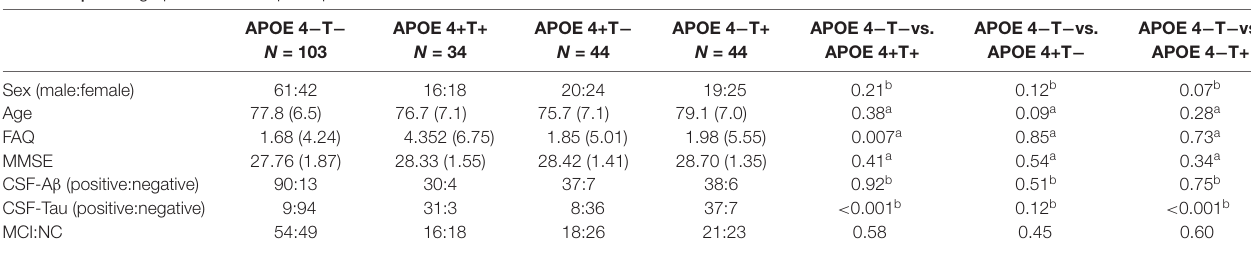
TABLE 1 | Demographic data of all